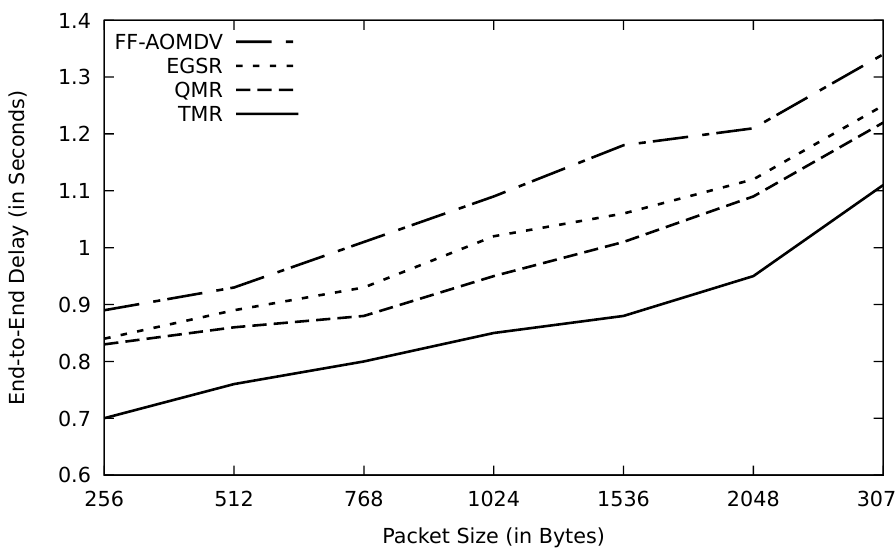
Figure 11. Comparison of FF-AOMDV, EGSR, QMR, and proposed protocol TMR for end-to-end delay with different packet